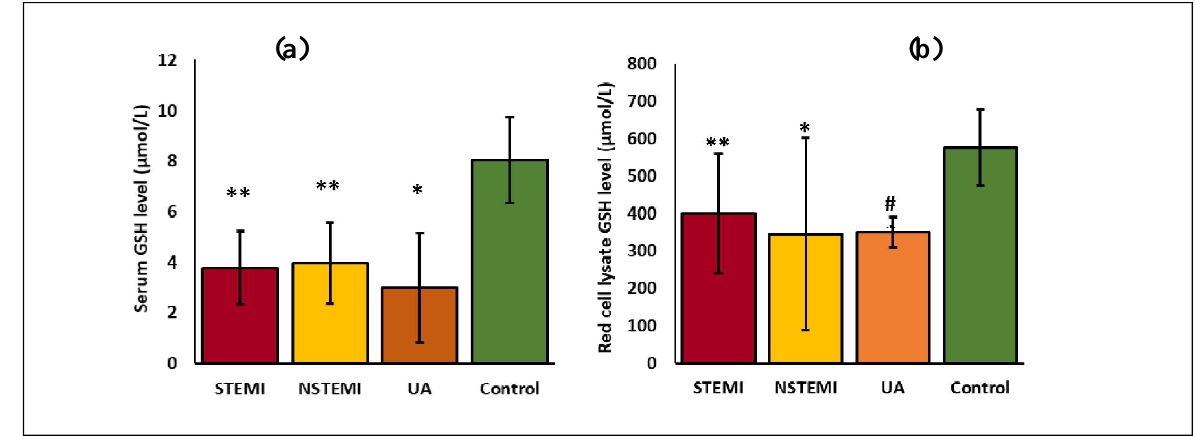
Figure 1: Comparison of the levels of (a) serum GSH, and (b) red cell lysate GSH among various ischemic subgroups of ACS patients and controls. Patients with ST-Elevation Myocardial Infarction (STEMI), Non-ST Elevation Myocardial Infarction (NSTEMI) and Unstable Angina (UA) had significantly lower GSH (reduced glutathione) in serum and red cell lysate than the respective controls; * p < 0.05, # p < 0.01 and ** p < 0.001.